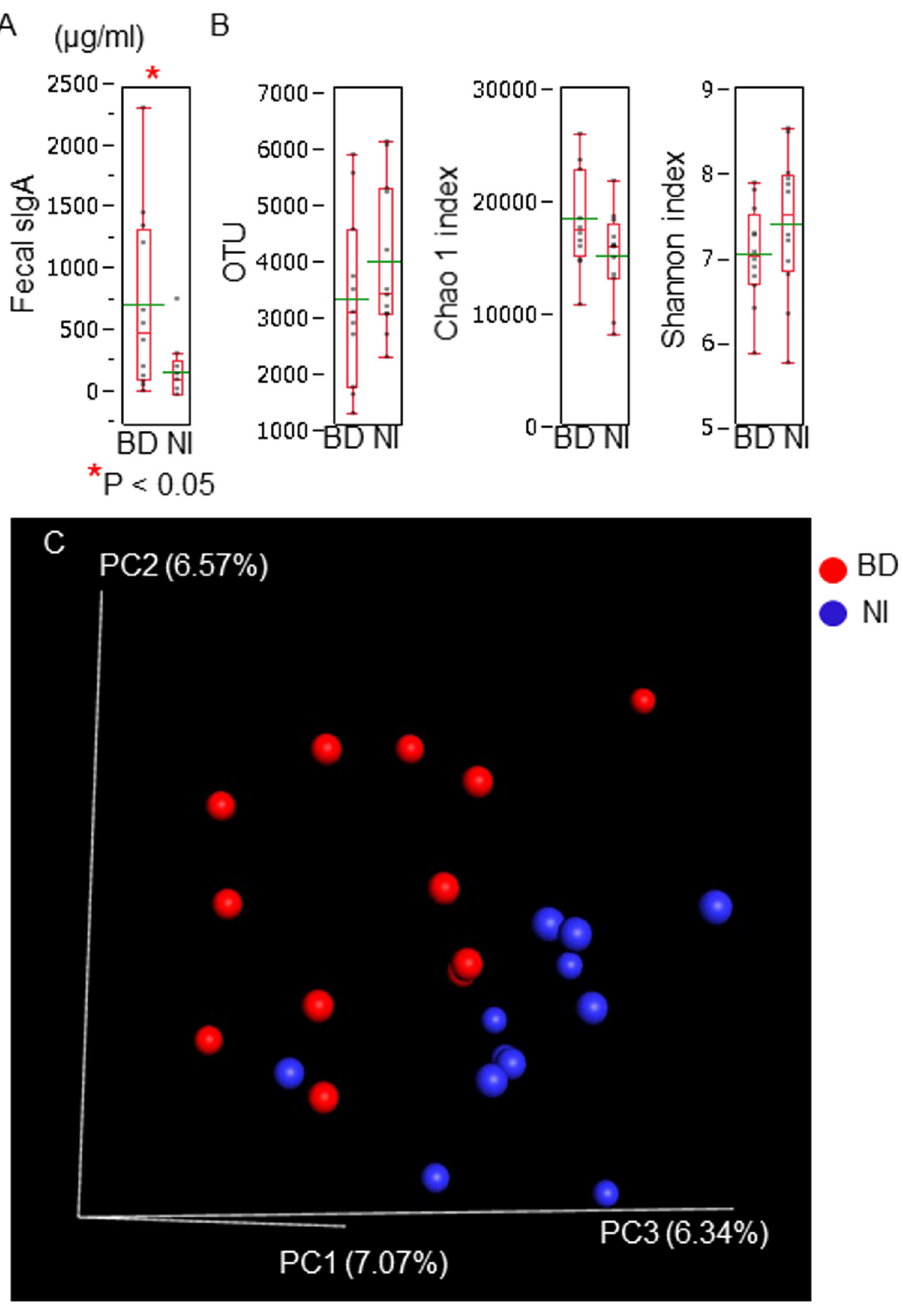
Fig 3. Comparison of fecal secretory IgA concentrations and bacterial diversity between BD patients and normal individuals. (A) We evaluated the secretory IgA (sIgA) concentrations of fecal supernatants using ELISA. We observed a significant increase in sIgA concentrations of patients with BD (BD) compared with those of normal individuals (NI). (B) We counted OTU numbers (annotated species numbers) and estimated alpha diversity score (Chao 1 and Shannon indexes) of each sample. We compared the titers between BD patients and normal individuals. We did not find significant differences in the parameters between BD patients and normal individuals. These biological parameters of BD patients and normal individuals were displayed with dot plots. A box-plot and a mean level (green line) of each group of BD patients and normal individuals were indicated. (C) We estimated beta diversity between BD patients and normal individuals using PCoA of QIIME software with linear conversion formulas. We visualized the PCoA plots in a three dimensional structure where three axes and each contribution ratio (principal